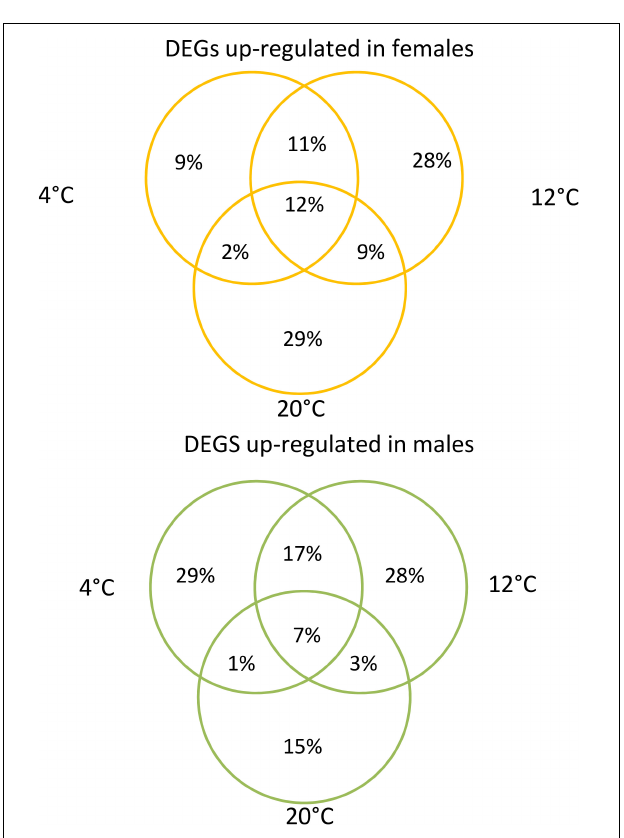
FIGURE 3 | Venn diagrams of DEGs between sexes of Saccharina latissima by temperature (Deseq2, p < 0.001; log 2 FC > 2, n = 3). Up and in orange: DEGs up-regulated in females, Down and green: DEGs up-regulated in males by temperature.